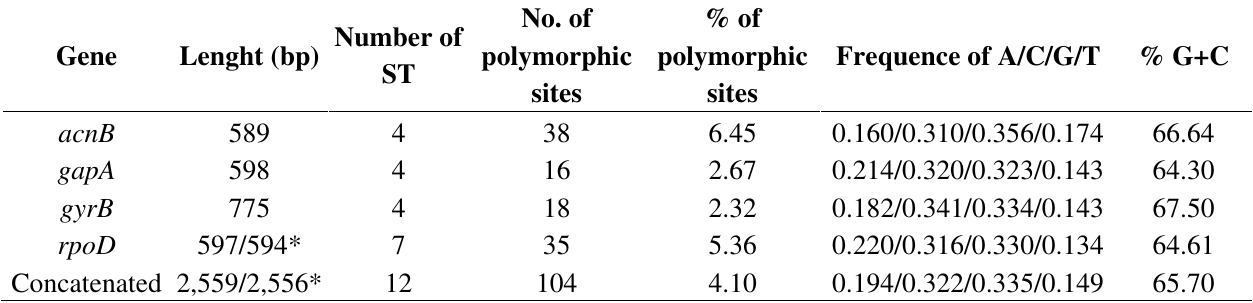
Table 2. Number of sequence types, polymorphic sites and nucleotide frequencies found in four housekeeping genes of Xanthomonas arboricola pv. Juglandis